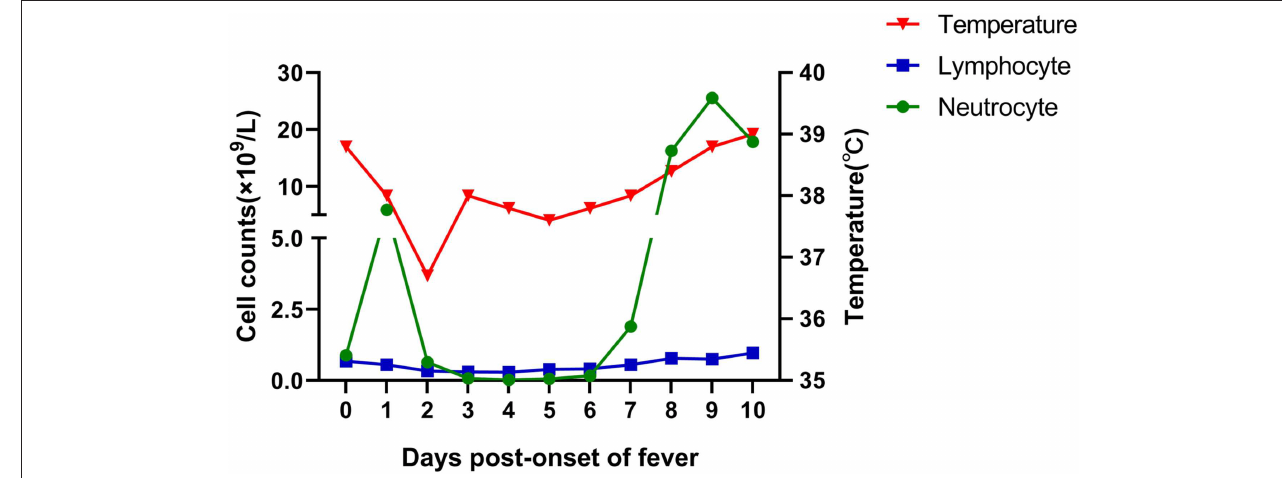
FIGURE 1 | Changes in maximum body temperature and blood cell count after the onset of fever.